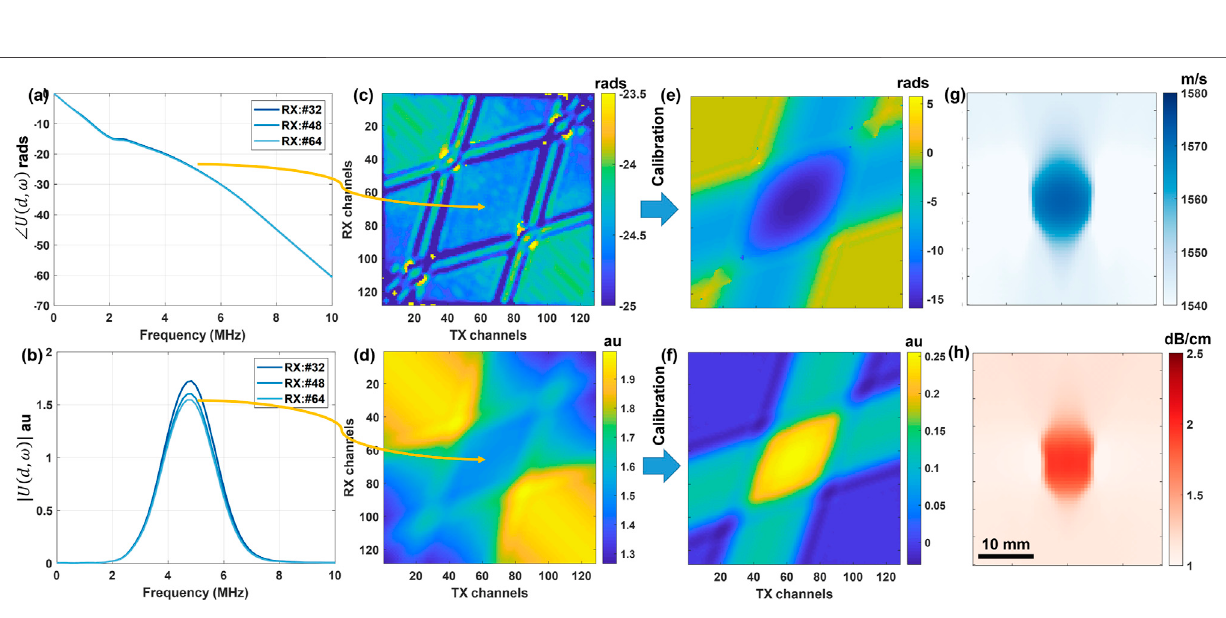
FIGURE 2 | Procedure of estimating SoS and UA distribution maps at frequency ω . 1D temporal Fourier transform is performed on the echo pro fi les obtained at different Rx channels to obtain (A) phase spectrum ∠ U ( d , ω ) and (B) amplitude spectrum | U ( d , ω )| for three sample pro fi les shown in Figure 1C . Phase and amplitude spectrum values for all Tx-Rx combinations at a selected sample frequency of 5 MHz are shown, respectively, in (C) and (D) . These values are then calibrated as described in Sec.2.2 leading to the calibrated phase (E) and amplitude (F) spectrum values, which are used for solving inverse problems to reconstruct local SoS (G) and UA (H) distributions at ω